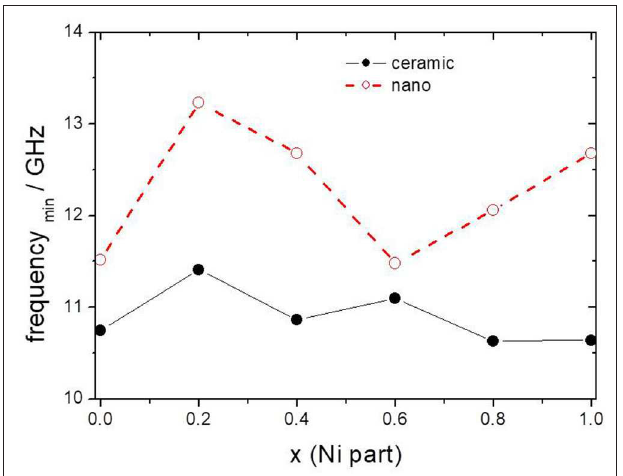
FIGURE 12 | The frequency of maximum attenuation depending on x (Ni content) in composite containing ceramic and nanoparticles of Ni x Zn (1 − x) Fe 2 O 4 .